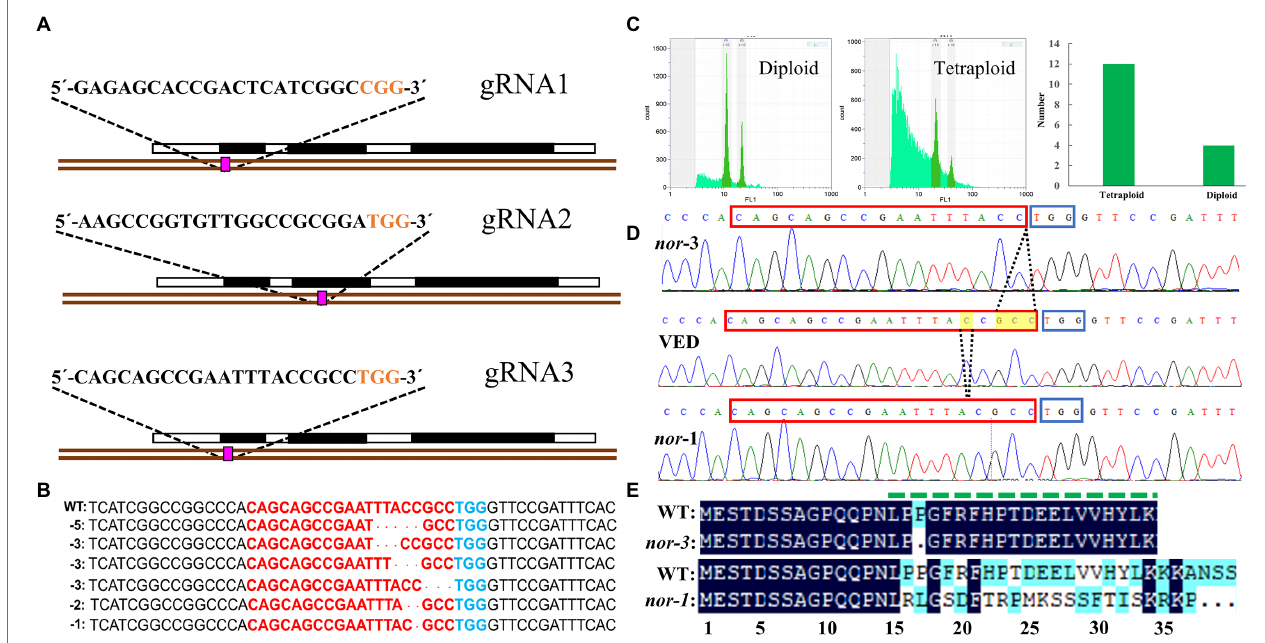
FIGURE 1 | Generation of CmNAC-NOR disrupted mutant lines by CRISPR/Cas9. (A) Illustration of the CmNAC-NOR gene structure and the three gRNAs in exons 1 and 3. (B) Six independent mutations at gRNA3 targeting sites. (C) Ploidy test of transgenic lines. Left, diploid line NOR-g3-22; Middle, tetraploid line NOR-g3-20; and Right, total number of diploid and tetraploid plants obtained. (D) Validated edited lines by Sanger sequencing. The yellow boxes and dotted lines indicate the deleted nucleotides and their position. (E) Amino acid alignment of the CmNAC-NOR gRNA3-target region in VED (WT), nor-3, and nor-1 . NAC subdomain A is shown by a dashed green line above the protein